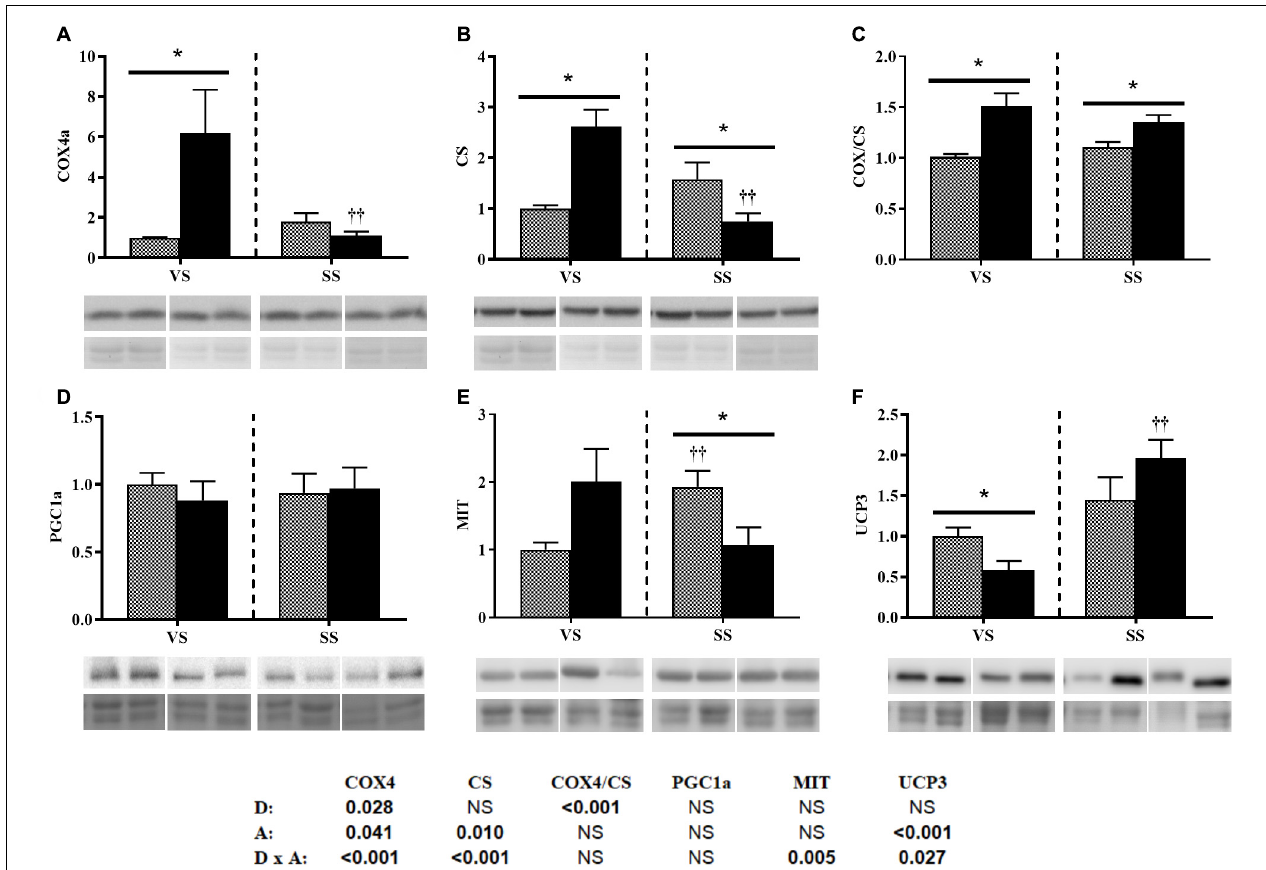
FIGURE 5 | Representative western blot and densitometric analysis of the protein levels of COX4 (A) , CS (B) , the COX/CS ratio (C) , PGC1a (D) , MIT1/2 (E) , and UCP3 (F) in the red skeletal muscle of gilthead seabream fed the HP or HE diet under conditions of (A) voluntary swimming (VS) or (B) sustained swimming (SS). Bands were normalized to their RevertTM total protein staining (the corresponding well is shown). To eliminate intermembrane variability, the relative intensity of each specific band was normalized by the geometric mean of the intensity of that of the VS HP diet group of the corresponding membrane. For COX4a and CS, the blots were performed from the same membranes which were split before the primary antibody incubation. Data are shown as the mean ± SEM ( n = 6). The factorial statistical analysis was assessed by two-way ANOVA and the p -values of the diet (D), swimming activity (A) and the interaction (D × A) are displayed at the bottom of the figure. Pairwise comparisons were assessed by unpaired Student’s t -test. ∗ p < 0.05 between diet groups (HP and HE); †† p < 0.01 between swimming activity groups (VS and